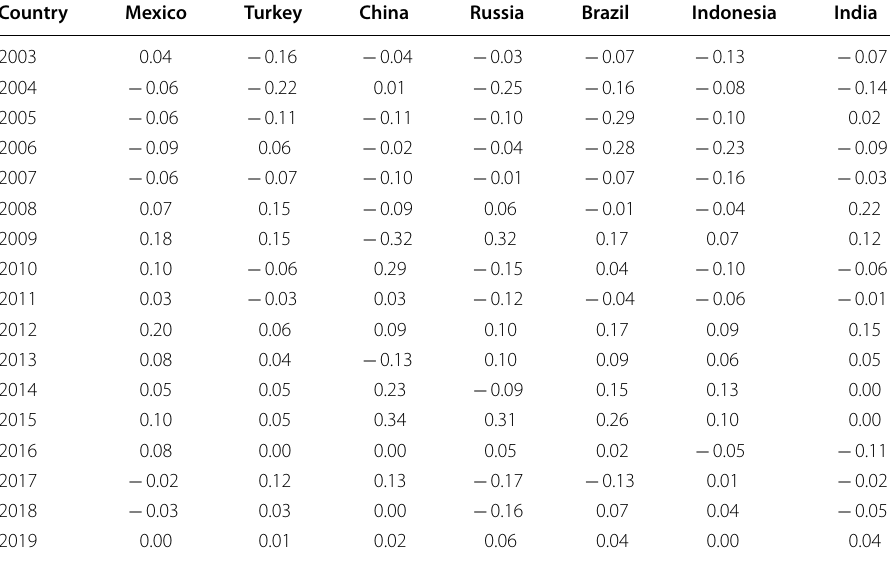
Table 7 Total external debt to GDP (annual changes), % Country